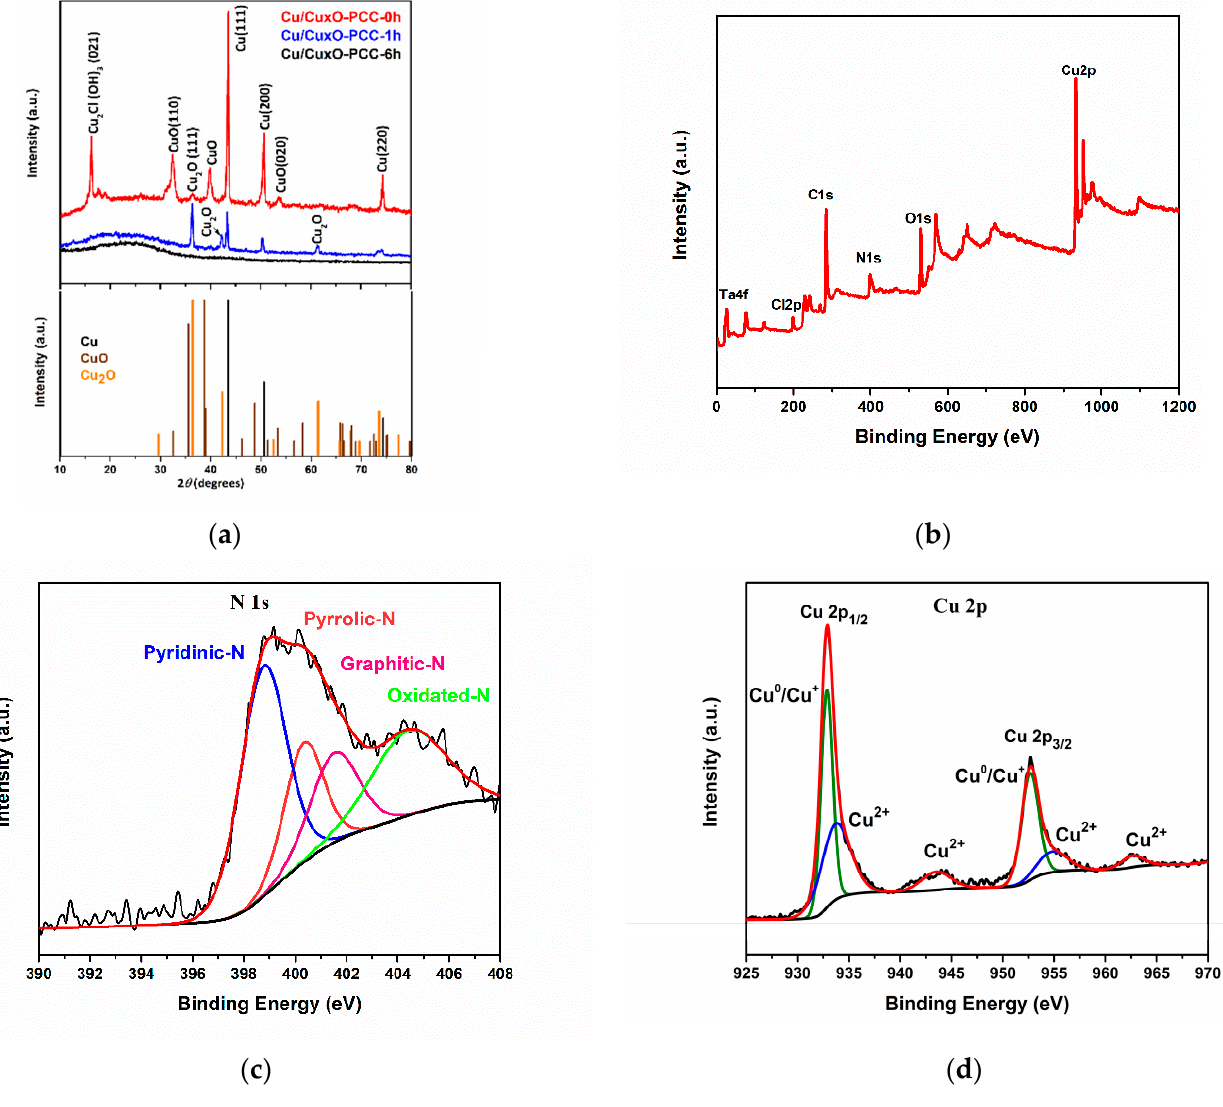
Figure 3. ( a ) XRD pattern, ( b ) XPS survey scan of Cu/Cu x O-PCC-0h, ( c ) High-resolution XPS spectrum of N 1 s for Cu/Cu x O-PCC-0h, ( d ) High-resolution XPS spectra of Cu 2p for Cu/Cu x O-PCC-0h.